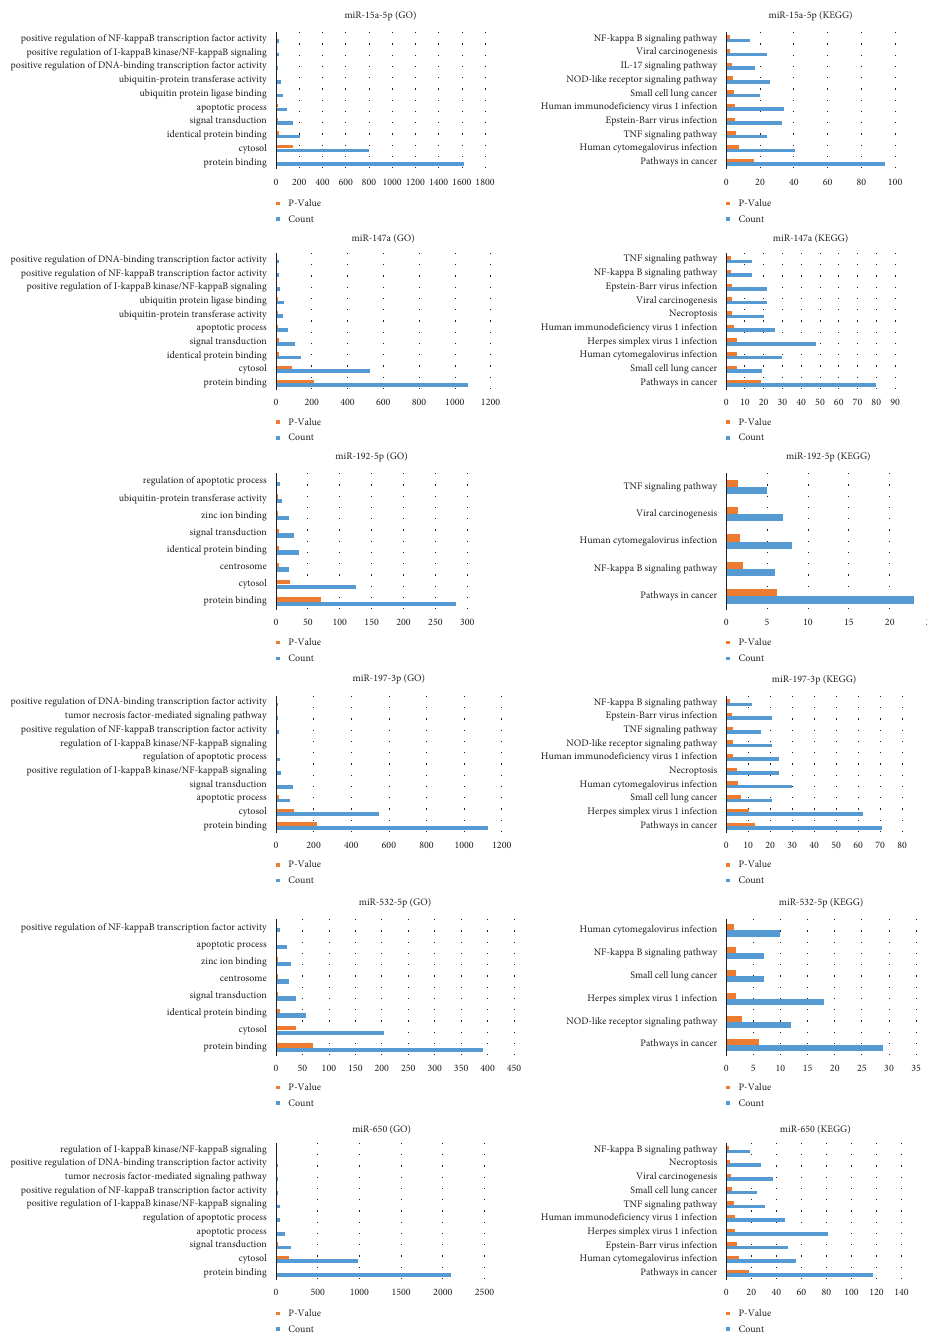
Figure 6: GO and KEGG enrichment analyses of TRAF5 in miR-15a-5p, miR-147a, miR-192-5p, miR-197-3p, miR-532-5p, and miR-650 using